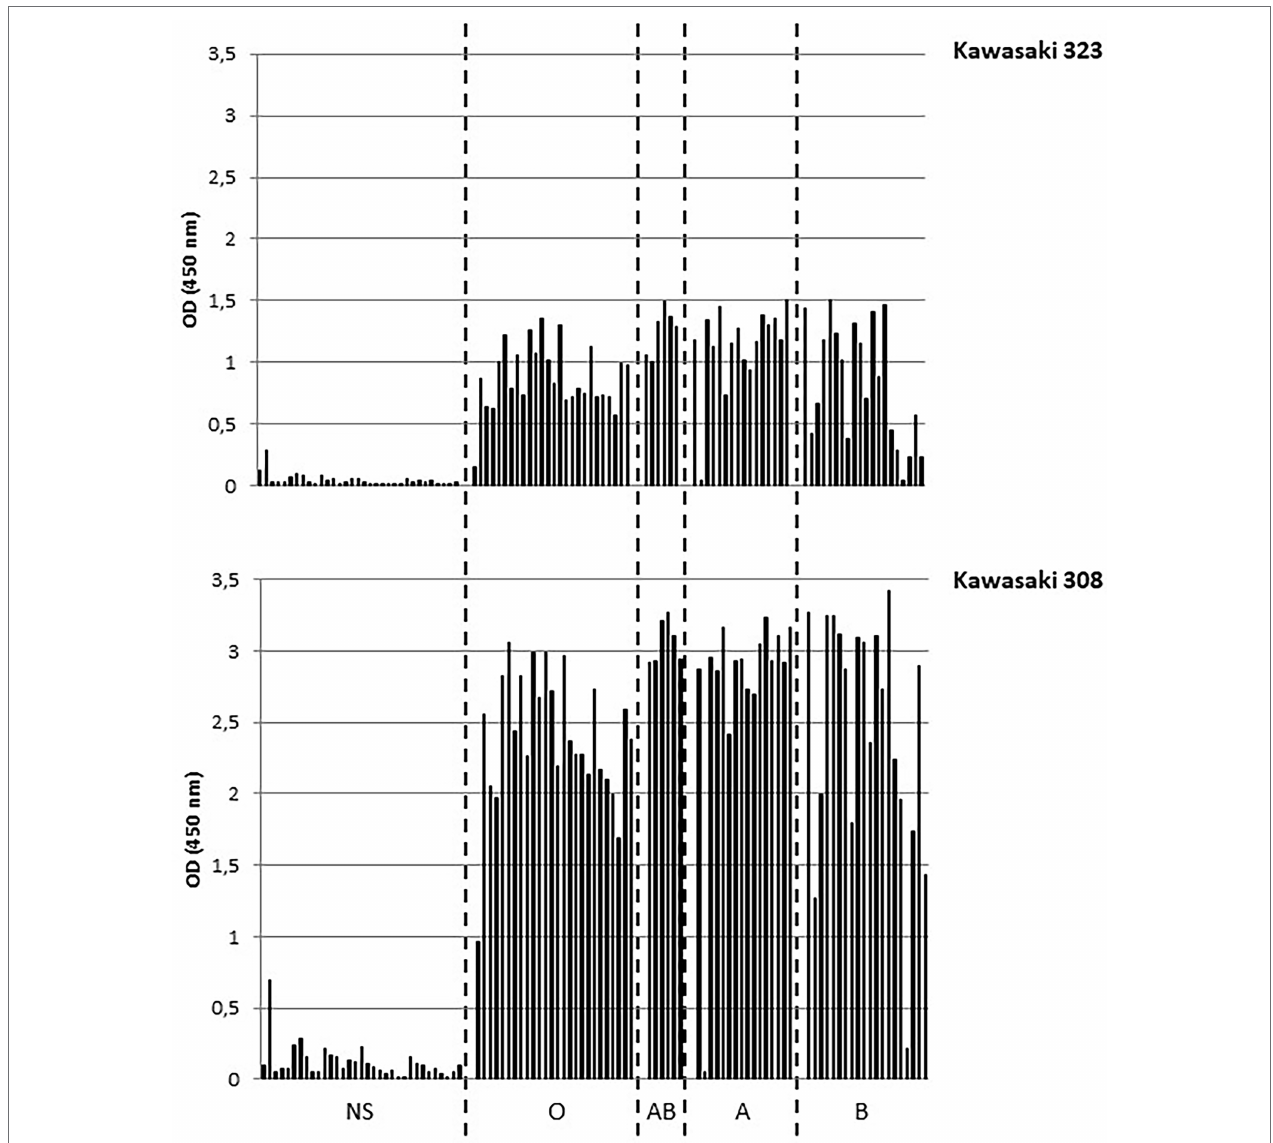
FIGURE 3 | Saliva binding assays. The binding of purified VLP was measured by ELISA. The experiments were performed in duplicate for each saliva sample and the mean values are shown on the graph. OD values at 450 nm wavelength are indicated on the y -axis for this graph and the following. The non-secretor saliva (NS) and the ABH(O) blood group for saliva from secretor individuals are indicated below the graph and are separated by dashed lines. The name of the variant is indicated on the right side of the